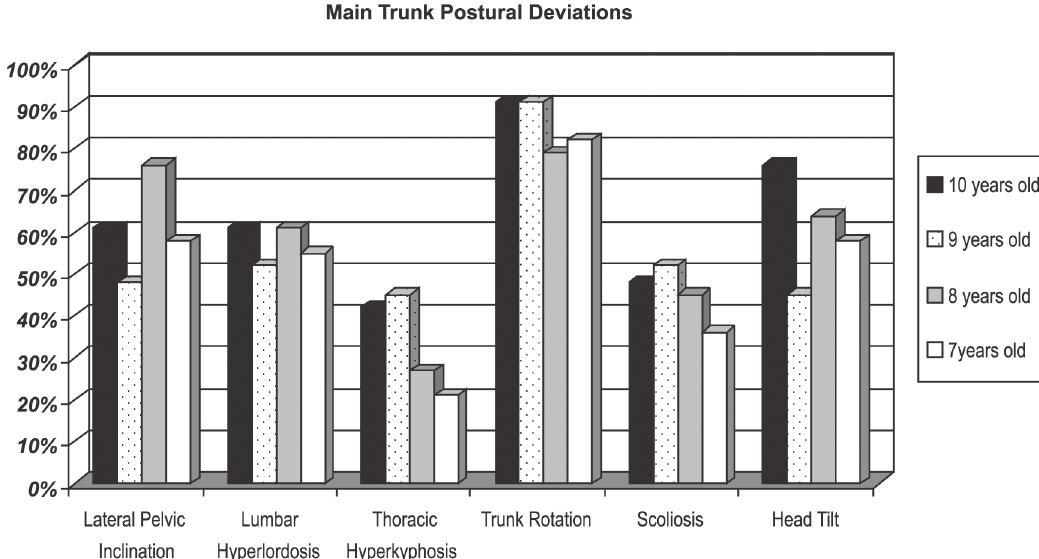
Figure 2 - Comparison among the postural deviations of the main trunk.